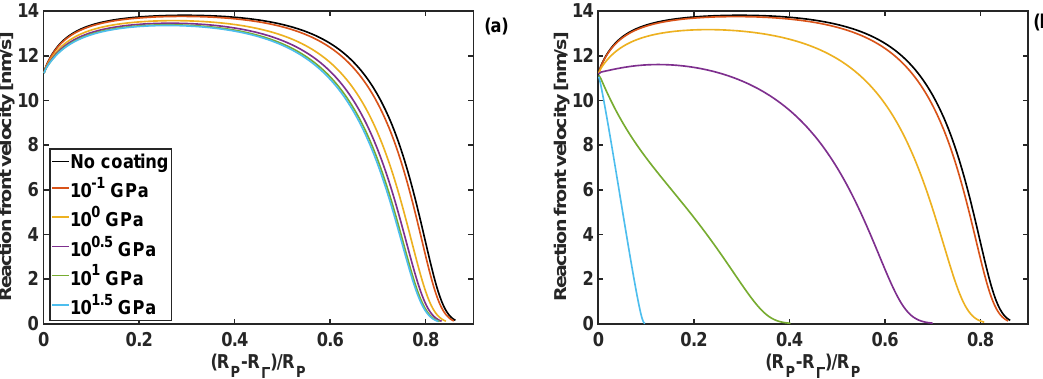
Figure 6: Profiles of reaction front velocity for different coating shear moduli; (a) K T =1 GPa Figure 6. Profiles of reaction front velocity for different coating shear moduli. ( a ) K T = 1 GPa and h = 10 nm. ( b ) K T = 10 GPa and h = 10 nm and h=10 nm; (b) K T =10 GPa and h= 10 nm thickness.